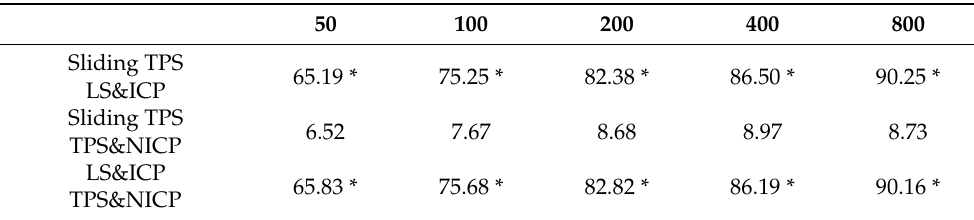
Table 10. The angles ( ◦ ) between allometric vectors (permutation test p < 0.05 *) derived at vary- ing densities.